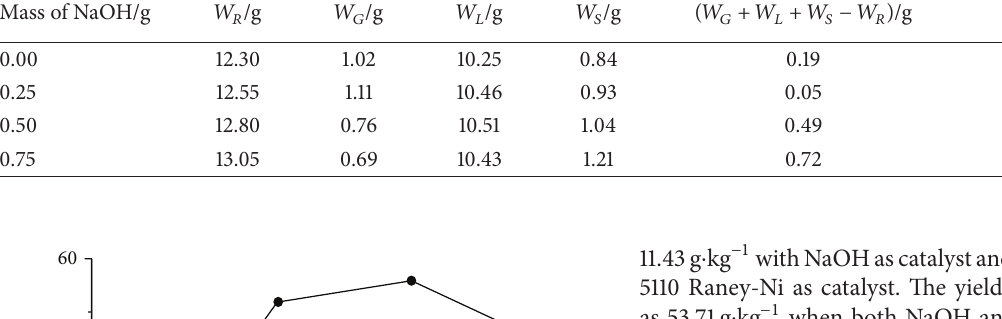
Table 7: Mass balance for the mixture of NaOH and Raney-Ni as catalyst. Mass of NaOH/g